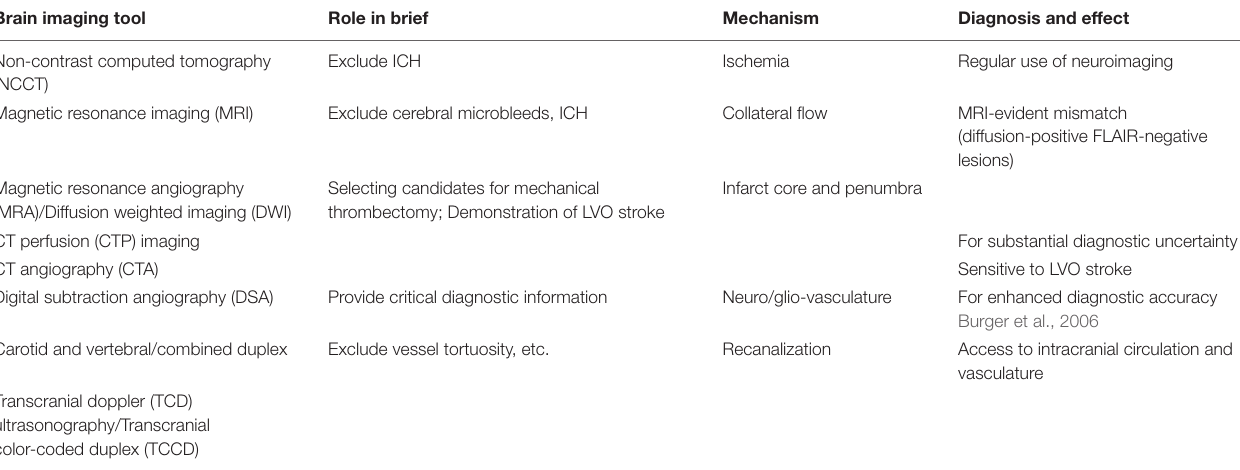
TABLE 1 | Brain imaging and general pathological information in acute ischemic